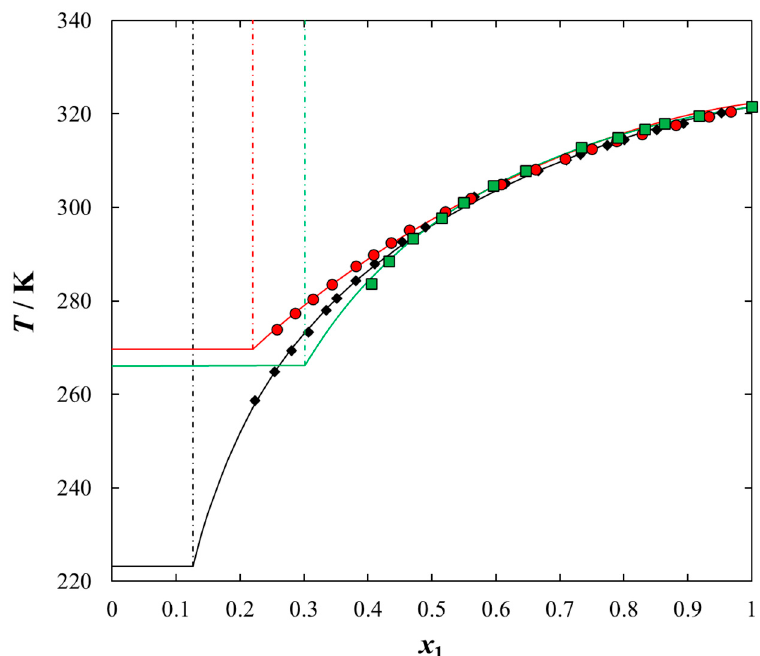
Figure 4. Experimental and calculated (solid + liquid), SLE and (liquid + liquid), LLE phase equilibrium data for {[BiQuin][NTf 2 ] (1) + organic sulfur compound (2)} binary system: ♦ , thiophene; ● , 2-methylthiophene; ■ , benzothiophene. Points are the experimental data; solid line is the correlation of NRTL model with parameters given in Table 5; dash-dotted line is the experimental binodal curve.